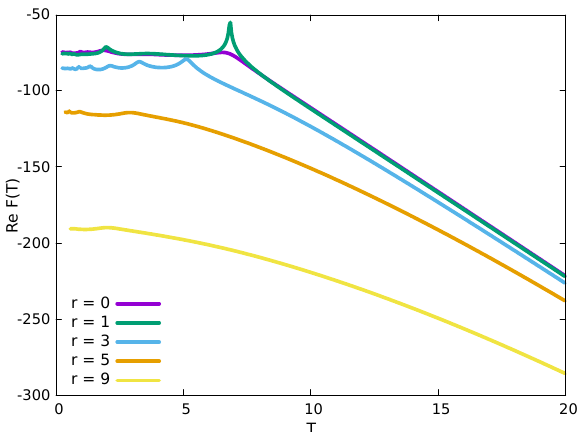
Figure 10: Real part of the free energy for z = re i π/ 6 for N = 34 and different r . As r increases, we observe a gradual reduction of the low temperature flat part until it almost disappears for r > 5. This feature is consistent with the gravity result of the previous